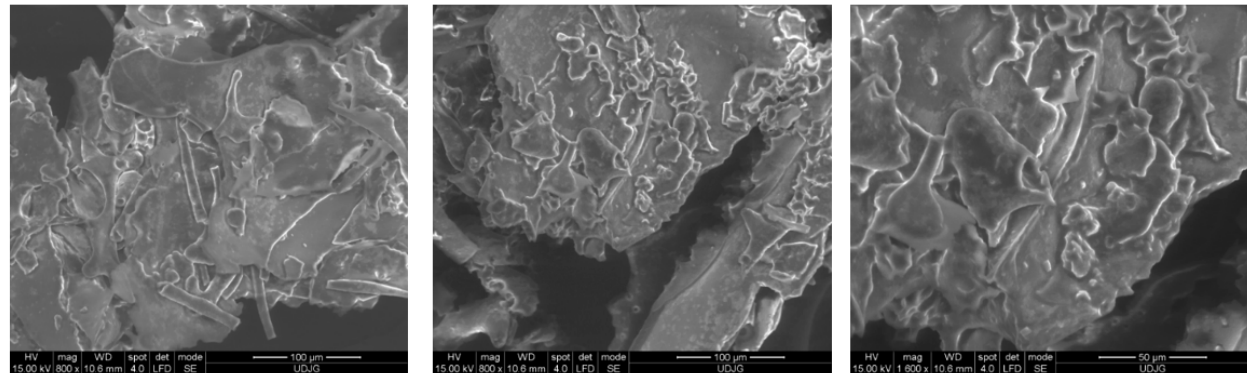
Figure 3. Scanning electron microscopy micrographs of freeze-dried rosehip pulp inoculated with Lactobacillus acidophilus.